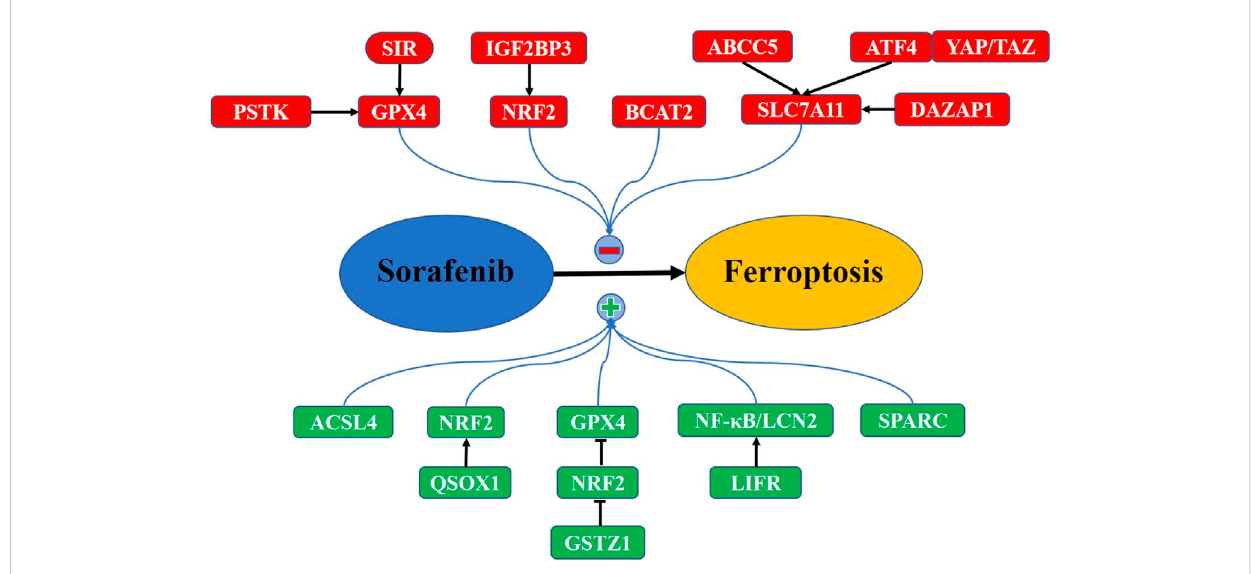
FIGURE 2 Keypathwaysinmodulationofsorafenib-mediatedferroptosisinHCC.Somenegativeregulators(red)inhibitsorafenib-mediatedferroptosis,which induces HCC resistance to sorafenib. Other positive regulators (green) promote sorafenib-mediated ferroptosis, sensitizing HCC to sorafenib (see